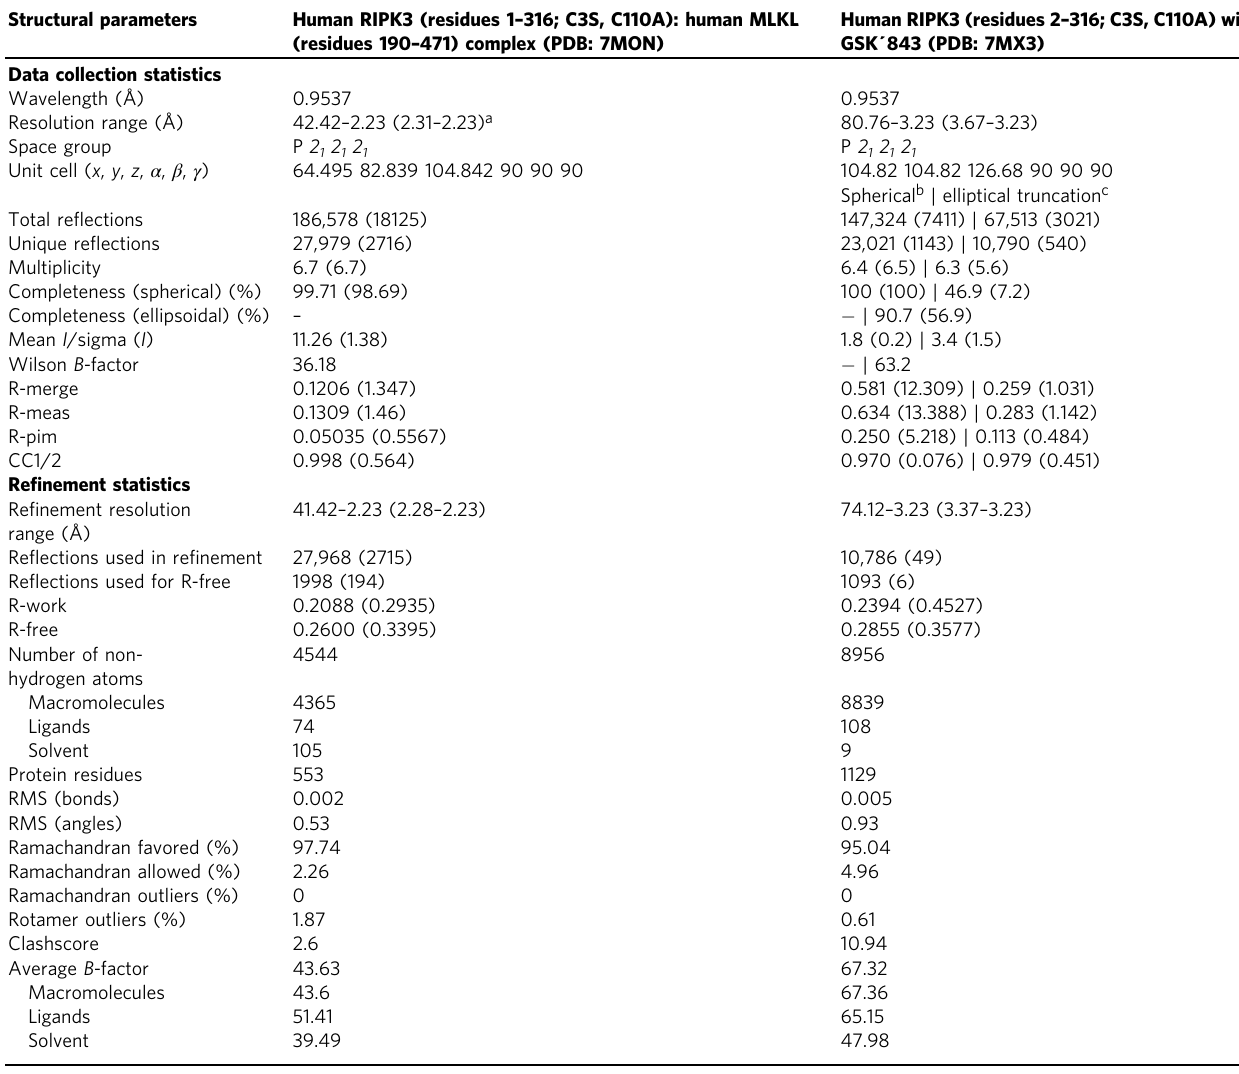
Table 1 X-ray crystallography data collection and re fi nement statistics. Structural parameters Human RIPK3 (residues 1 – 316; C3S, C110A): human MLKL (residues 190 – 471) complex (PDB: